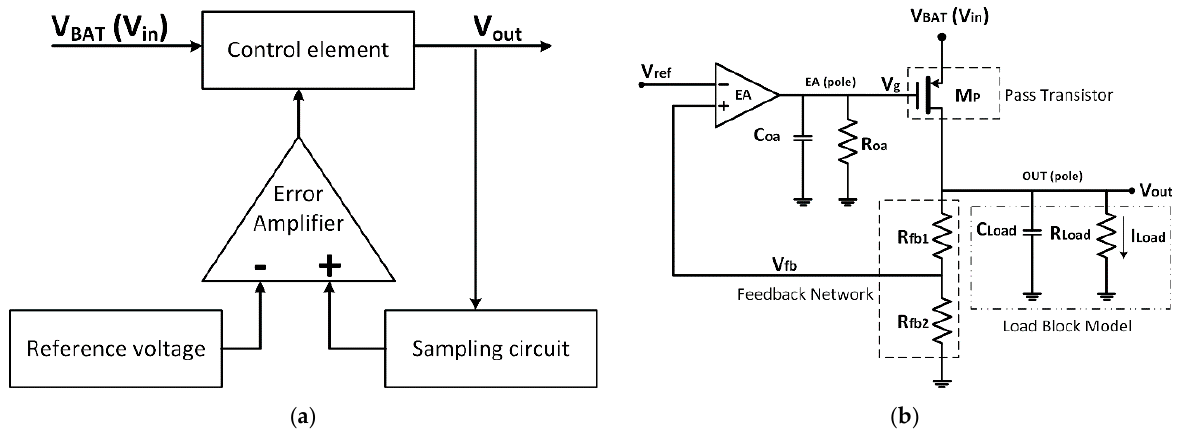
Figure 2. ( a ) Conceptual scheme of a linear regulator and ( b ) schematic view of a complementary metal–oxide–semiconductor (CMOS) LDO regulator.